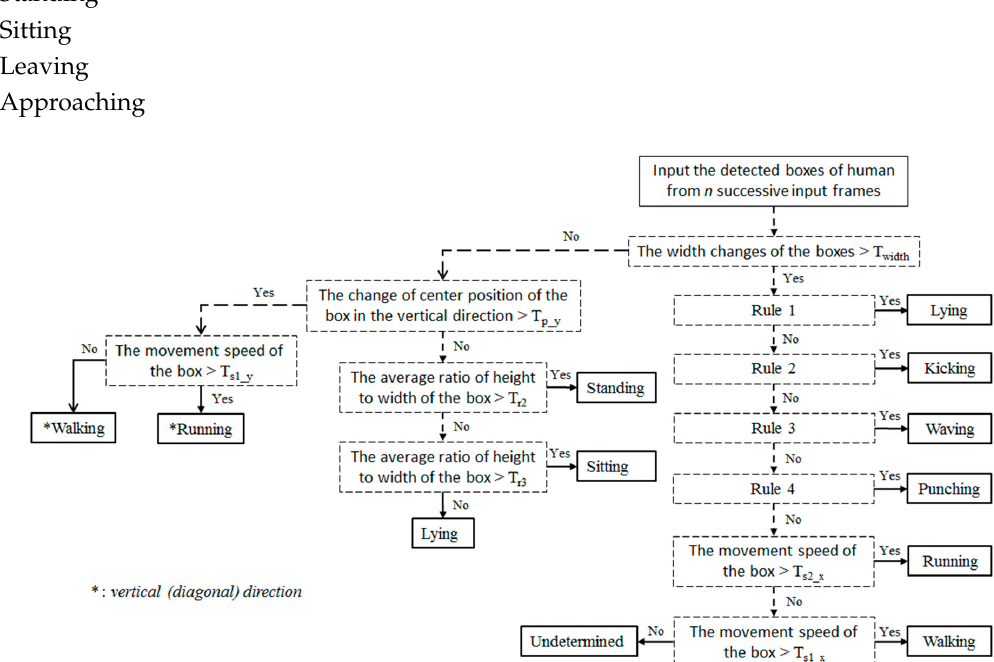
Figure 3. Flowchart of the proposed method of behavior recognition.